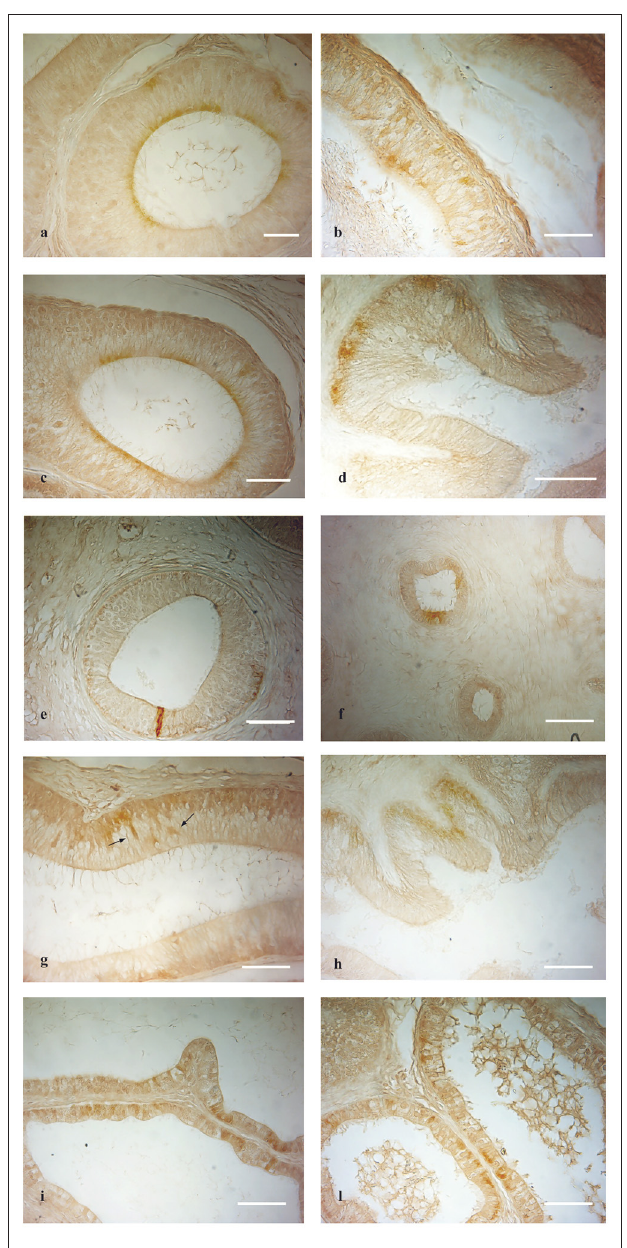
FIGURE 3 | OXB- and OX2R-IR in normal and cryptorchid epididymis: (a,b) OXB-IR was found in the apical and basal portion of the principal cells of the normal caput and corpus epididymis. (c,f) In the cauda of normal and cryptorchid epididymis, in which the immunoreactivity was found in the apical portion of principal cells in both normal and cryptorchid cauda epididymis. (d) In cryptorchid caput only the basal portion of the principal cells are positive. (e) In cryptorchid corpus, rare cells show immunoreactivity. (g,h) OX2R-IR was described in the basal portion of the principal cells. Moreover, OX2R-IR was detected in narrow cells [ (g) , arrows]. (i,l) In the normal dogs, OXB and OX2R were distributed in the epithelium lining the epididymal efferent ductules, respectively. Bar: 10 µ